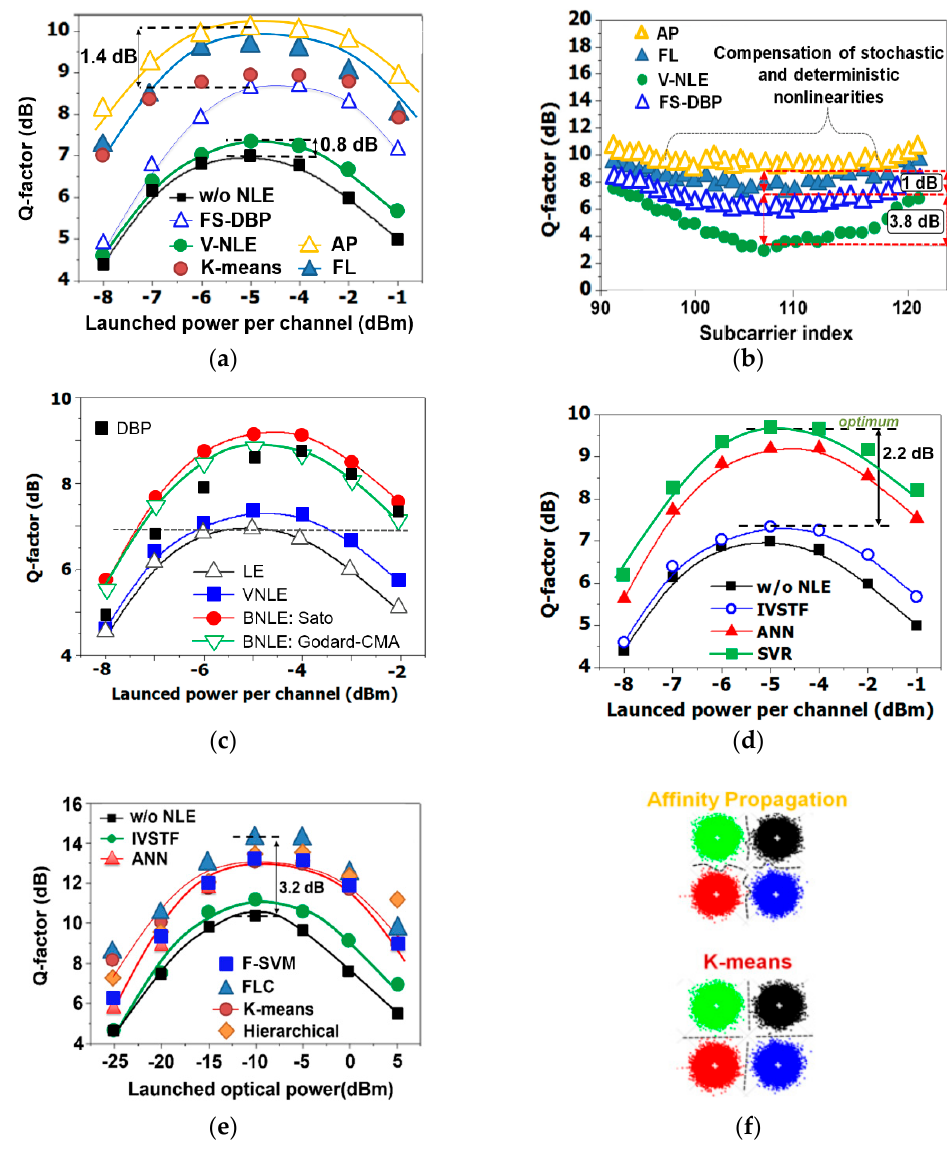
Figure 11. WDM QPSK CO-OFDM results [22,28,29,33,35,36] ( a ) Q-factor vs. launched optical (LOP) per channel among clustering and deterministic algorithms. ( b ) Middle subcarriers Q-factor distribution at − 5 dBm of LOP (optimum). ( c ) Q-factor vs. LOP for unsupervised SVMs. ( d ) Performance comparison between supervised support vector machine-regression (SVR) and artificial neural network (ANN). ( e ) Performance comparison between Fast-Newton-SVM (F-SVM) and benchmark clustering/deterministic algorithms. ( f ) Received constellation diagrams for affinity propagation (AP) and K -means at − 7 dBm of LOP. LE: linear equalization; NLE: nonlinear equalization; V-NLE/IVSTF: inverse Volterra-series transfer function NLE; BNLE: blind NLE; FS-DBP: full-step digital back-propagation; FC/FLC: Fuzzy-logic